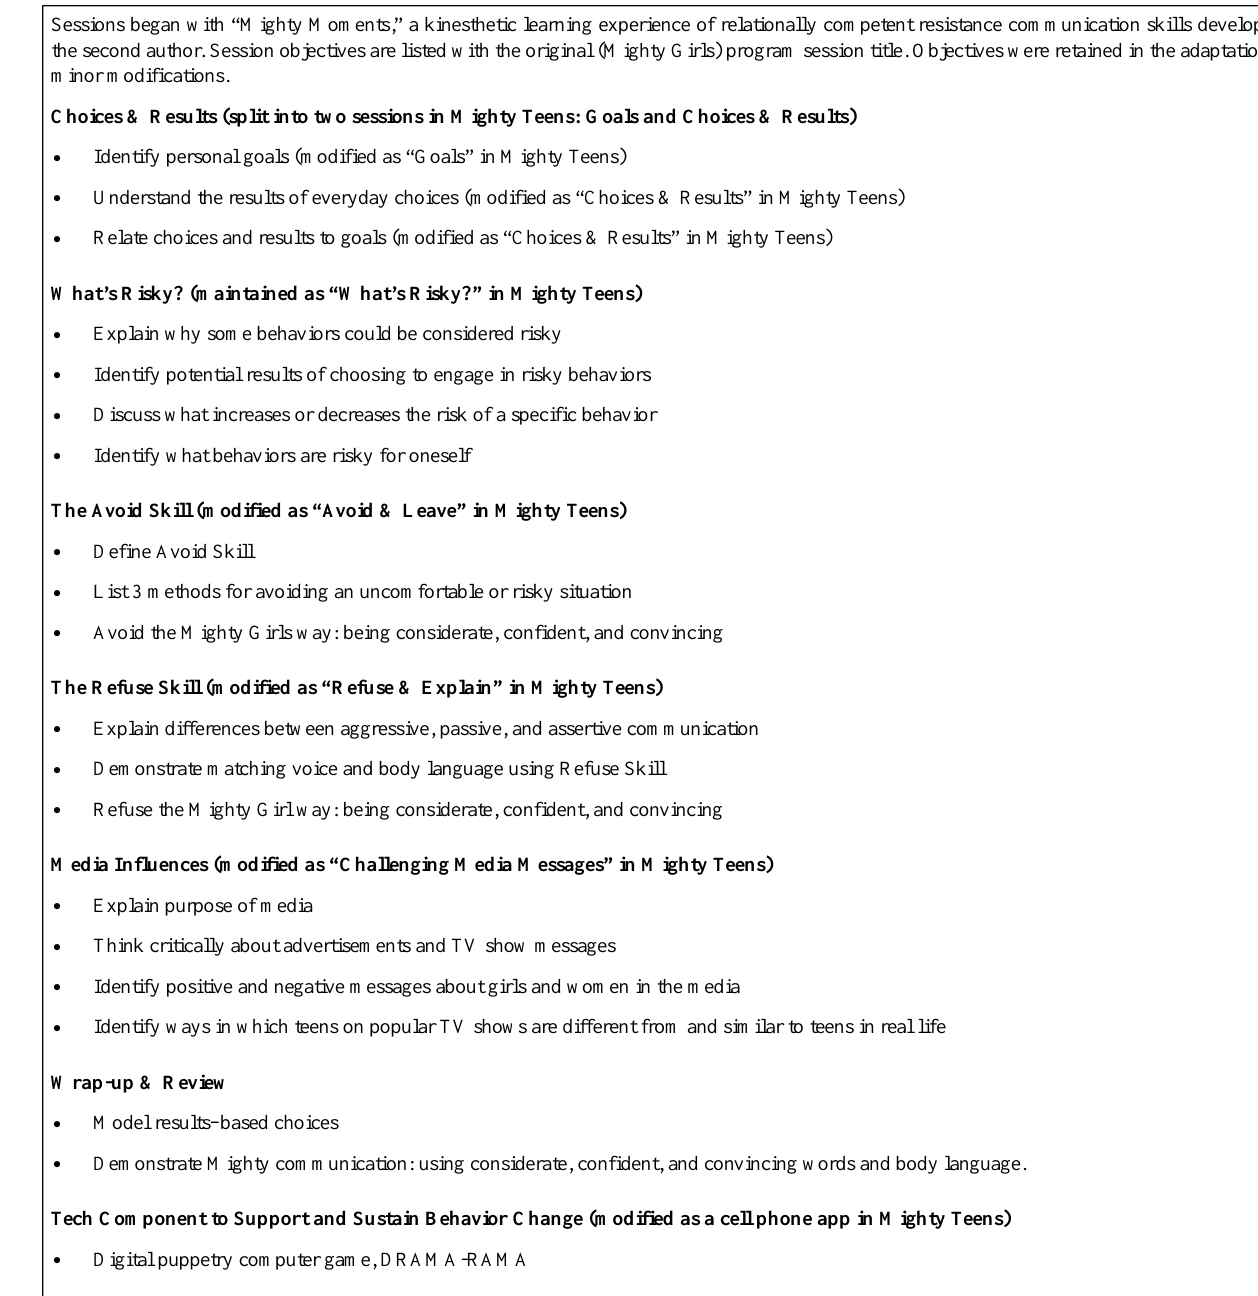
Textbox 1. Mighty Girls program components and corresponding components in the Mighty Teens